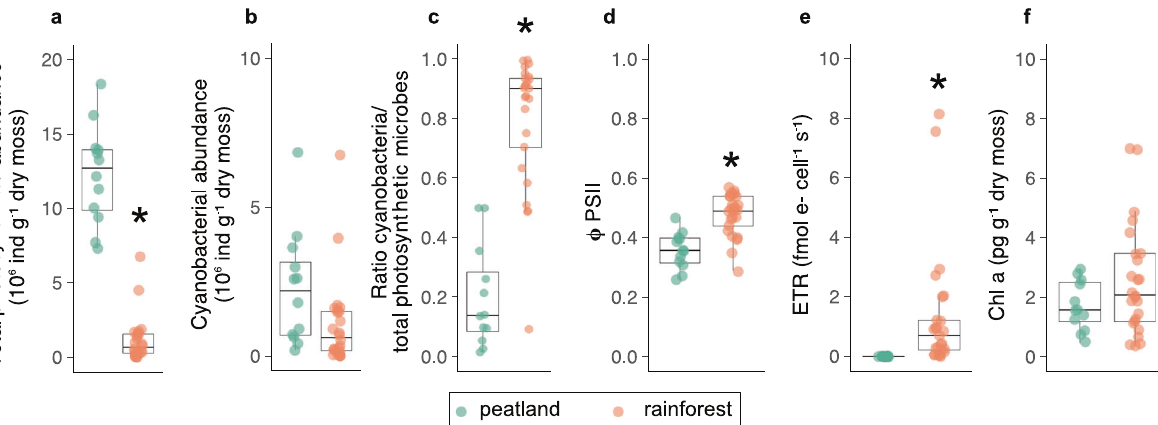
Fig. 3 Photosynthetic microbial properties. The abundance of all photosynthetic microbes ( a ), cyanobacteria ( b ), and the ratio between cyanobacterial abundance and total photosynthetic microbial abundance ( c ) in each type of bryosphere. Photosynthetic ef fi ciency ( Φ PSII, d ), photosynthetic electron transport rate per cell (ETR) ( e ), and chlorophyll-a cellular content of photosynthetic microbes in both types of bryosphere ( f ). Signi fi cant differences ( P < 0.05, ANOVA Type III error) are indicated by asterisks.